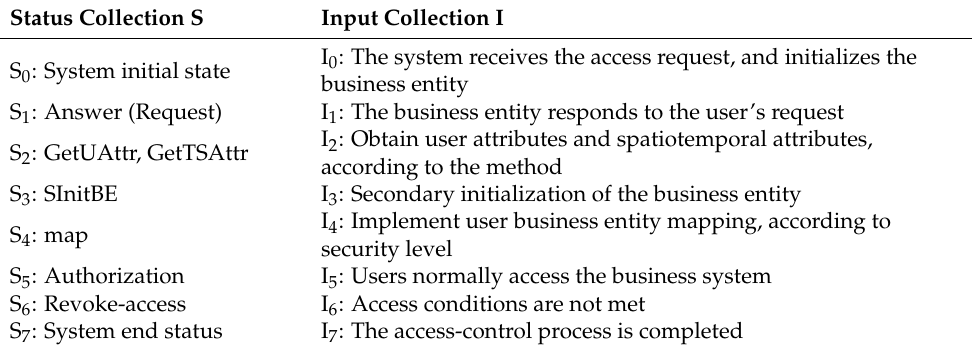
Table 2. Access-control state settings